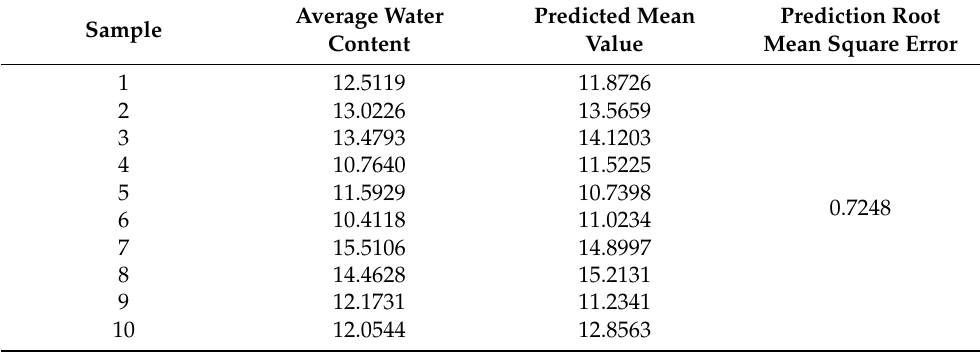
Table 5. Mean value and comparison results of dry basis moisture in different lettuce leaf parts. Average Water Predicted Mean Prediction Root Sample Content Value Mean Square Error 1 12.5119